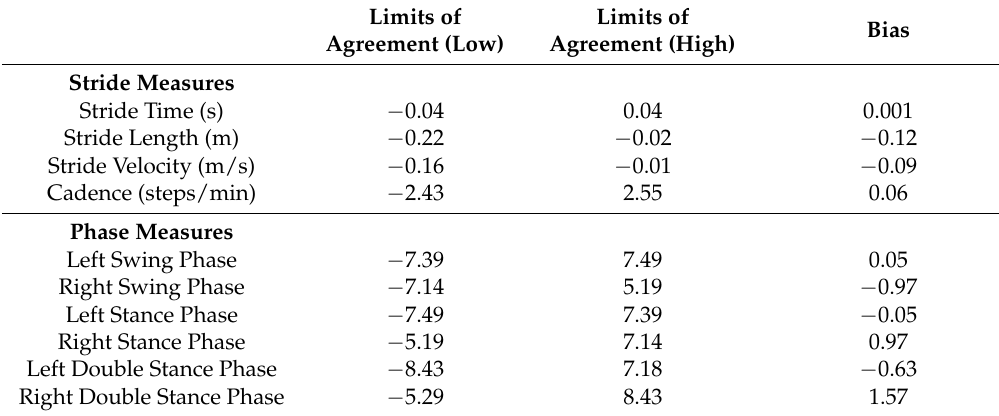
Table 1. Bland altman limits of agreement and